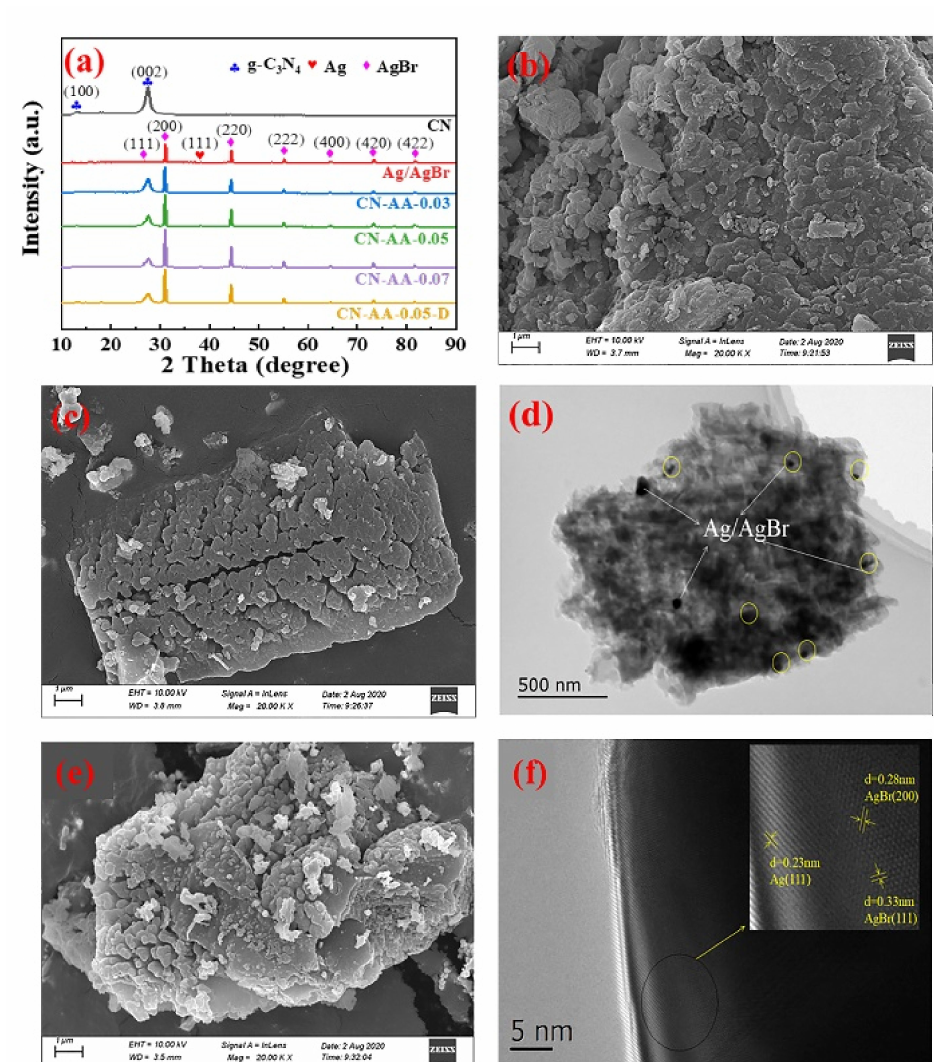
Figure 1. ( a ) XRD patterns of CN, Ag/AgBr, CN-AA-X(X = 0.03, 0.05 or 0.07), CN-AA-0.05-D. ( b ) The SEM image of CN. ( c ) SEM images of CN-AA-0.05 and ( d ) TEM images of CN-AA-0.05. ( e ) The SEM image of CN-AA-0.05-D. ( f ) The HRTEM image of